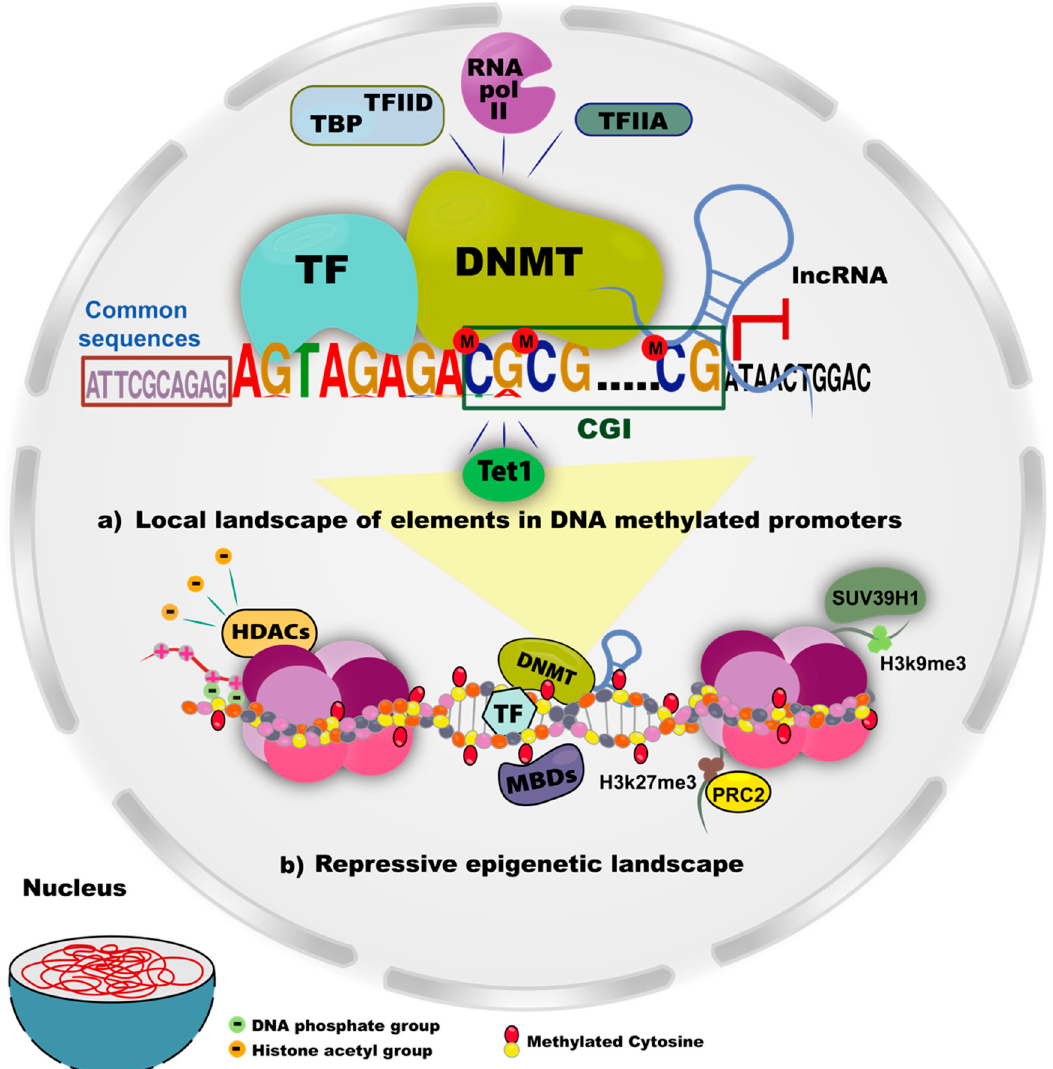
Figure 4. Elements closely related to DNA methylation and repressive epigenetic landscape. ( a )